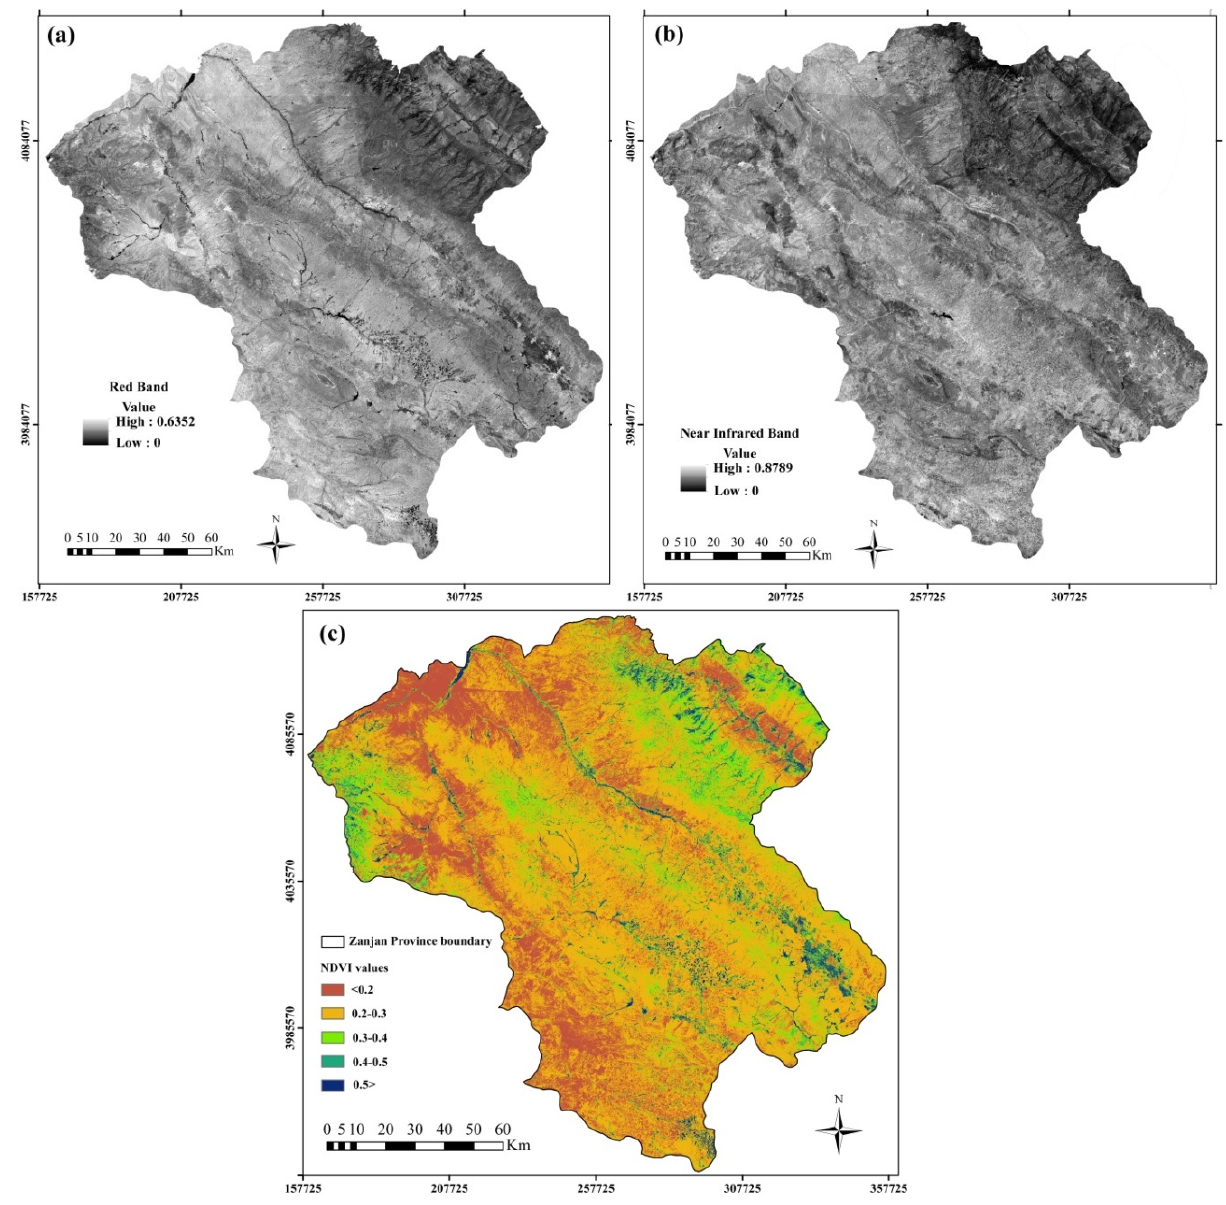
Figure 4. Sentinel red and infrared bands along with NDVI resultant map: ( a ) Red band image, ( b ) Infrared band, and ( c ) The NDVI factor map.